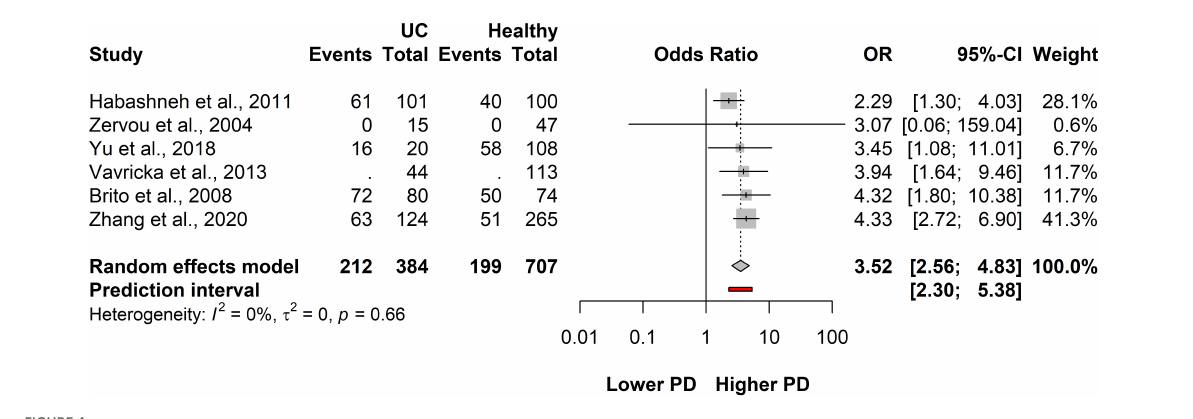
FIGURE4 Forest plot showing the association between ulcerative colitis (UC) and